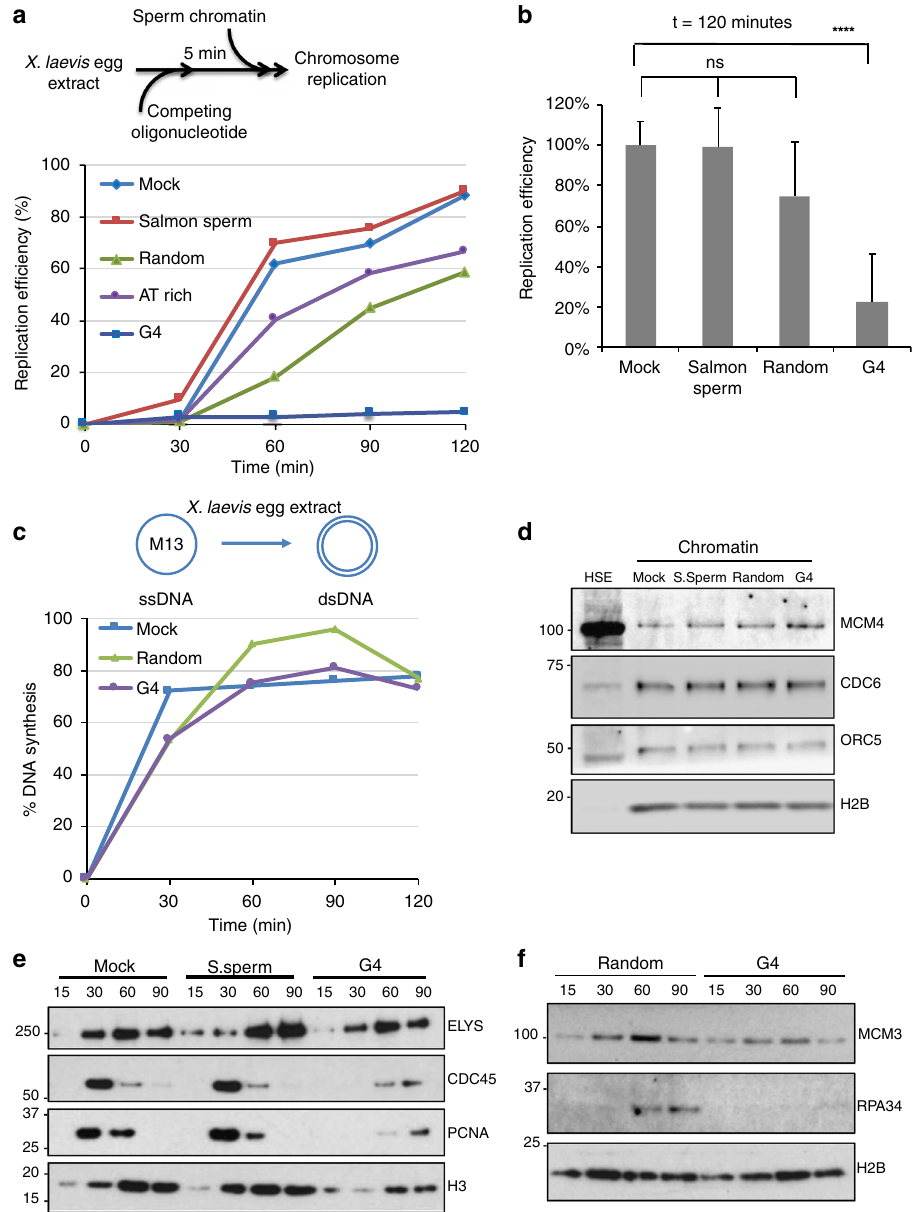
Fig. 6 At the activation step of DNA replication, OGRE/G4 elements compete for dsDNA but not for ssDNA replication. a Schematic representation of the replication kinetics of sperm nuclei in X. laevis low-speed egg extracts (LSE) in the presence of competing double-stranded (ds) oligonucleotides. LSEs were pre-incubated with competing oligonucleotides, sonicated salmon sperm DNA, or ultrapure H2O (mock) at 22 °C for 5 min. b Average DNA replication ef fi ciency (mean + SD) of LSEs pre-incubated with competing oligonucleotides or controls ( n = 6 for mock/salmon sperm DNA pre-incubated extracts, n = 3 for mock/random oligonucleotides). Total incubation time was 2 h. P values were obtained using the two-tailed Student ’ s t test; **** p < 0.0001, p > 0.05. c Replication kinetics of ssM13 complementary DNA strand synthesis in X . laevis high-speed egg extracts (HSE) pre-incubated with the indicated competing oligonucleotides or H2O (mock). d Competition by OGRE/G4 oligonucleotides does not affect pre-RC formation. Sperm nuclei were added to HSEs incubated with H2O (mock), sonicated salmon sperm DNA (S.Sperm), or the indicated oligonucleotides. Chromatin was isolated and immunoblotted with the indicated antibodies. Histone H2B level was used as loading control. e , f Competition by OGRE/G4 oligonucleotides affects DNA replication activation. Time-course analysis of replication initiation factor recruitment to chromatin after addition of sperm nuclei to LSEs pre-incubated with H2O (mock), sonicated salmon sperm DNA (S. sperm), or competing oligonucleotides. At the indicated time points, chromatin was isolated and immunoblotted with the indicated antibodies; ns not signi fi